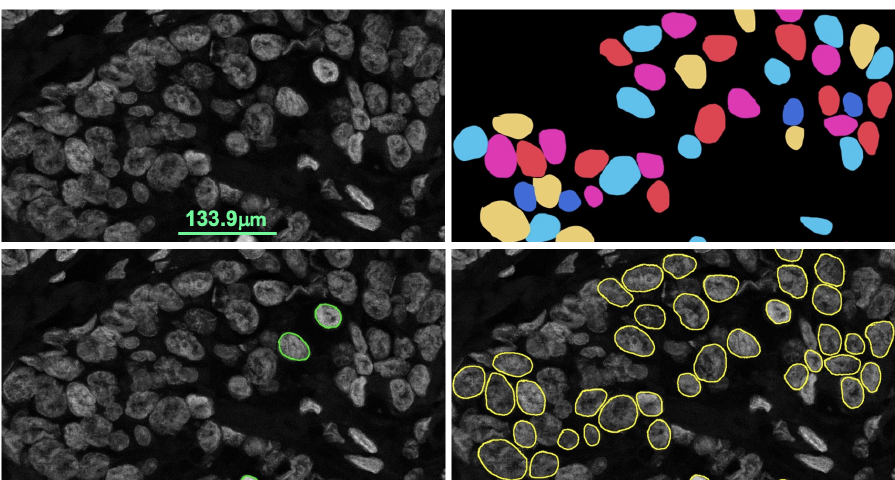
Figure 11. Proposed method outperformed the SVM based nuclei detection. Original image ( top left ), ground truth ( top right ), SVM detection ( bottom left ) and proposed U net segmentation ( bottom-right ).